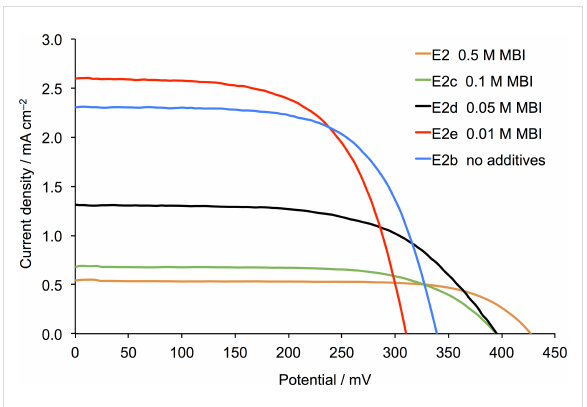
Figure 4: J–V curves for DSCs with dye 1 and electrolytes E2 and E2b–E2e. The curves were recorded on the day of sealing the DSCs.